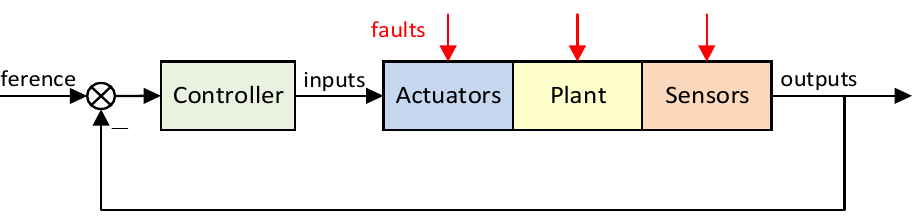
Figure 1. Faults in a control system.